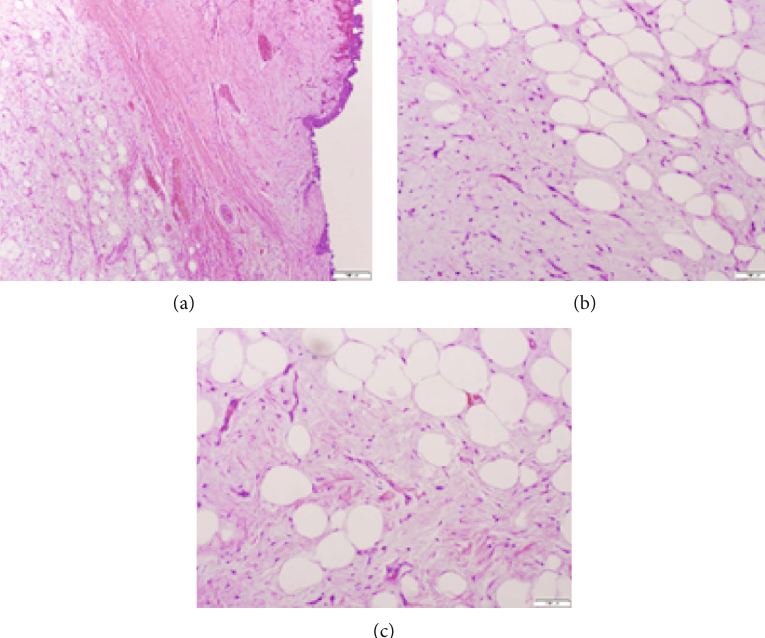
Figure 6: Excisional biopsy of the right middle lobe lesion showing myxoid respiratory tissue with mature adipocytes surrounded by a thick capsule without invasion (a). Characteristic spindle cells with ropey/wavy collagen with interspersed mature adipocytes (b, c), suggestive of a myxoid spindle cell